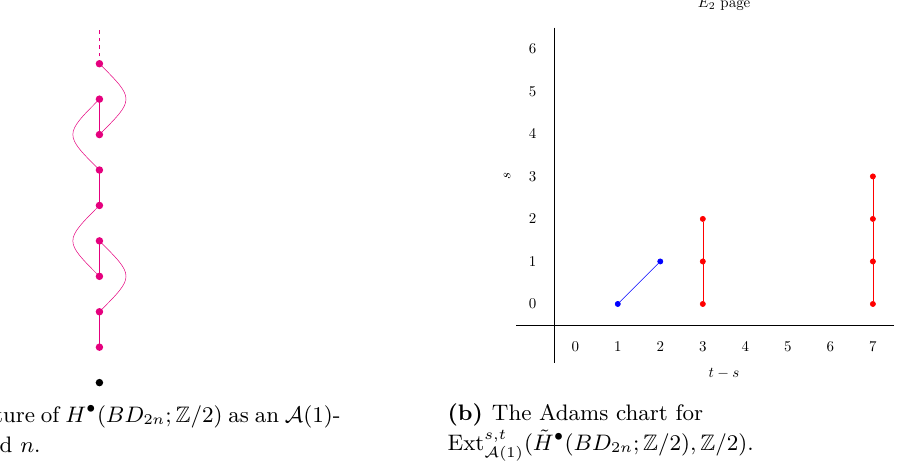
Figure 2. The A (1) -module structure and Adams chart for calculating spin bordism of BD 2 n , for odd n